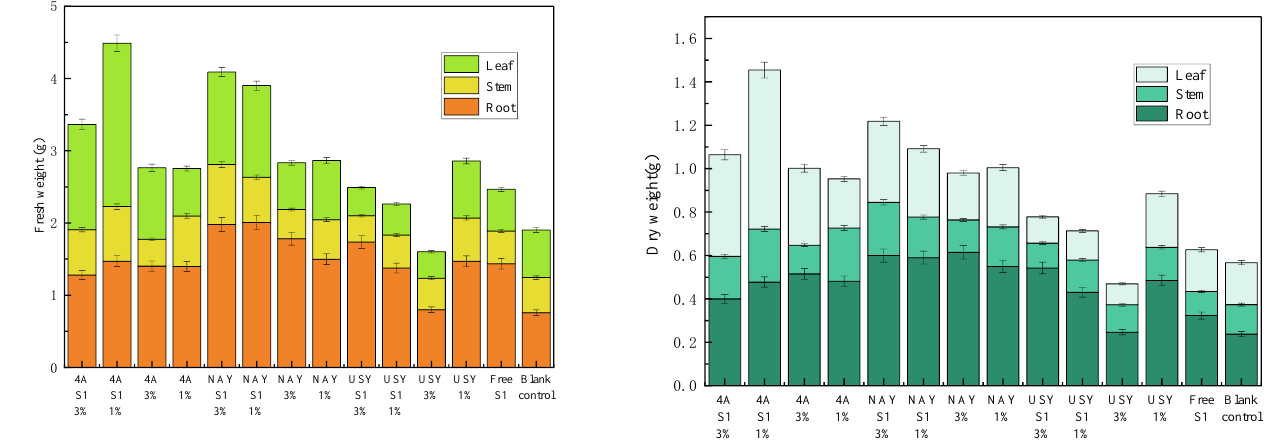
Figure 11. The effect of zeolite and bacteria on plant fresh weight and dry weight.